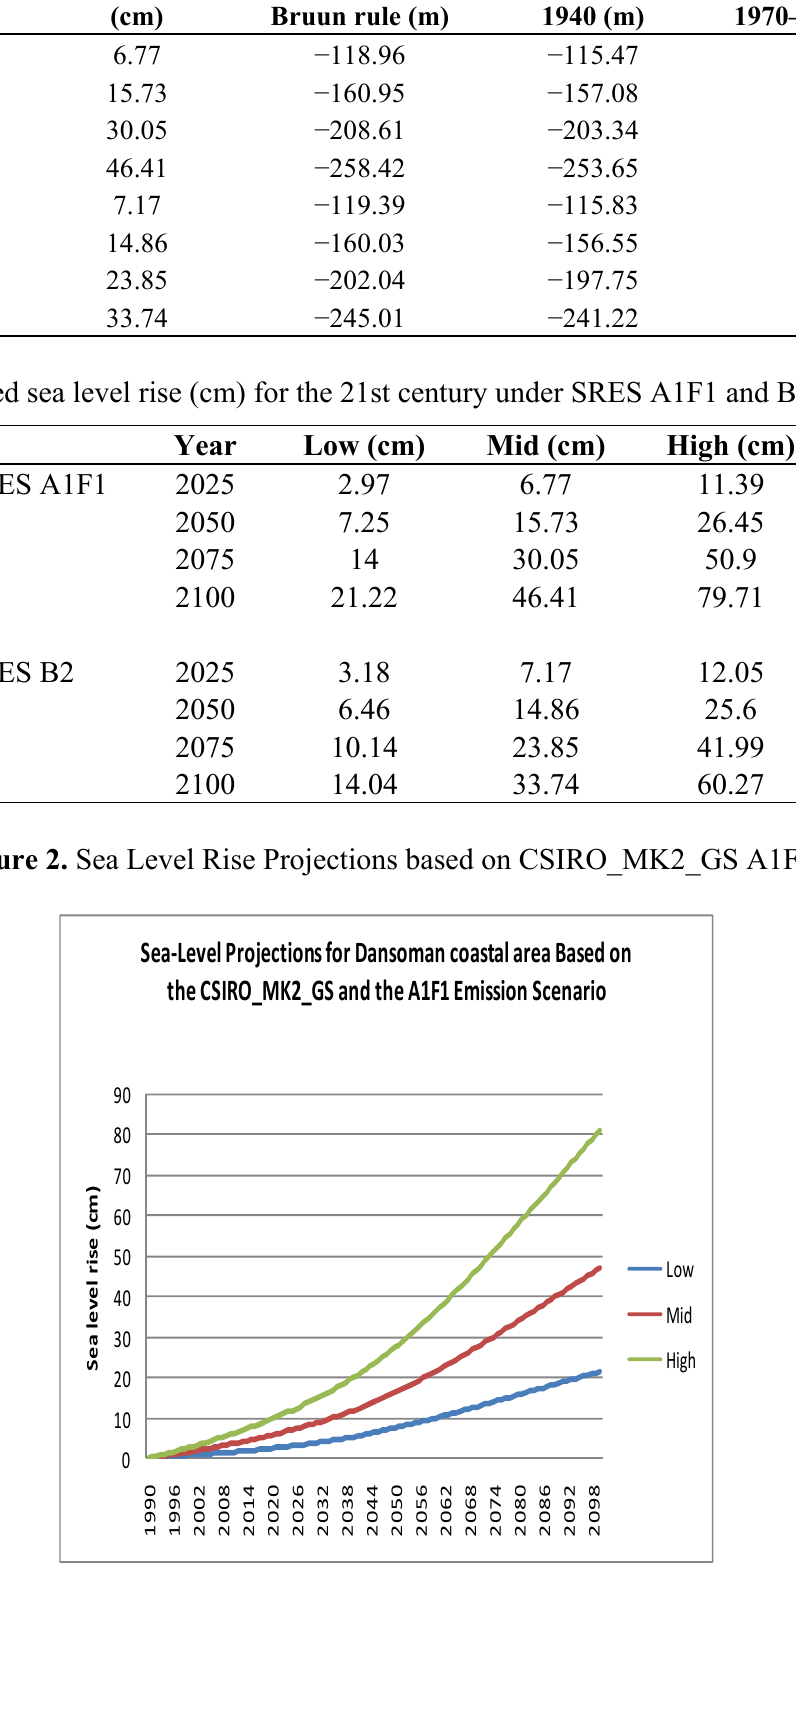
Equilibrium Current shoreline Shoreline position shoreline from with baseline from with baseline from (cm) Bruun rule (m) 1940 (m) 1970–1990 average (m)